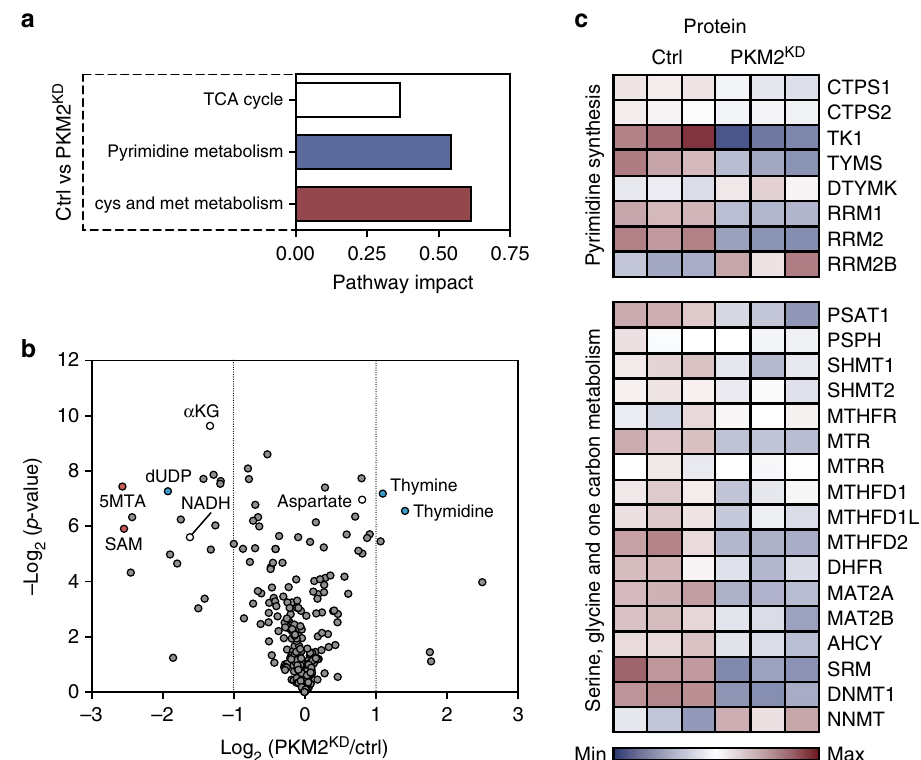
Fig. 4 Loss of PKM2 leads to coordinated metabolic and protein expression changes. a Analysis of steady-state metabolite levels in control vs PKM2 KD ECs identi fi es the TCA cycle, pyrimidine metabolism and cysteine and methionine metabolism as signi fi cantly regulated pathways. b Metabolomics pro fi le of control vs PKM2 KD ECs (log 2 (fold change) vs − log 2 ( p value), two-tailed Student's t test, n = 3). c Heat map of protein expression for key enzymes in the pyrimidine synthesis and serine, glycine, one-carbon metabolic networks in control vs PKM2 KD